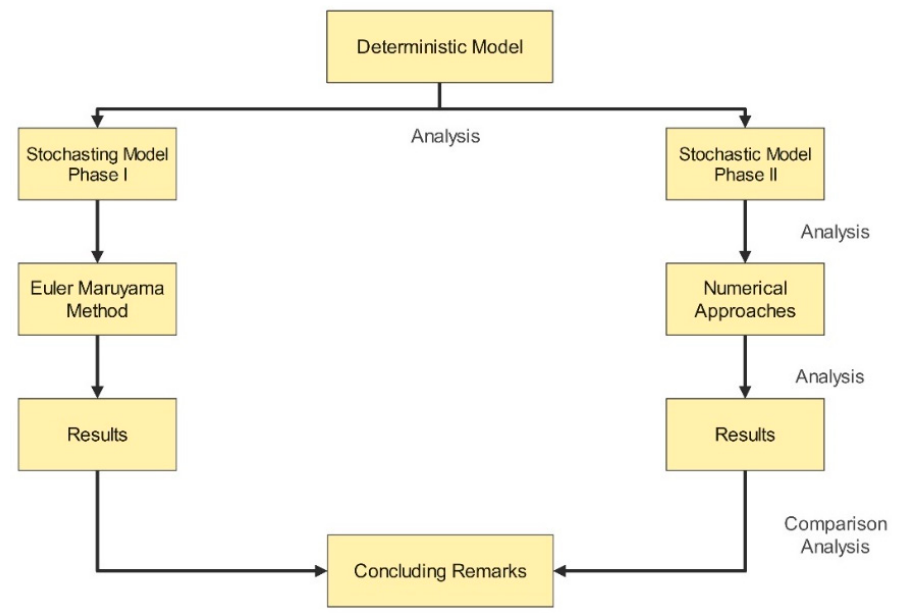
Figure 4. A schematic diagram of the Lassa fever model.